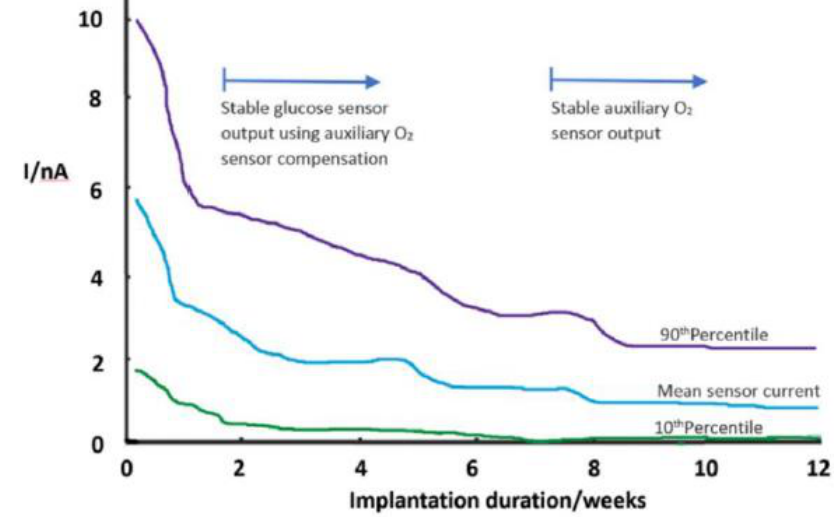
Figure 8. Auxiliary oxygen sensor current decay in subcutaneously implanted glucose sensors in pigs. Data represent one week moving averages of daily mean sampled currents and the spread of data for 60 electrodes. Adapted from [96].